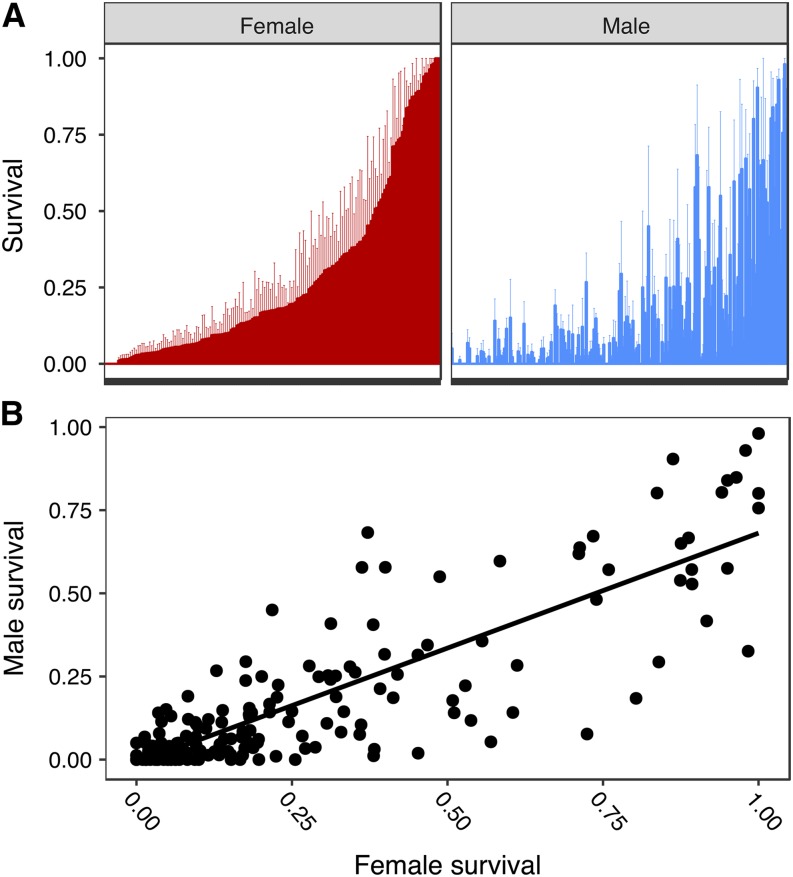
Adult survival phenotype showing A.) mean survival ± SE for each line after 6 h of anoxic exposure. Survival is sorted by female survival. B) Male and female survival was strongly correlated (r = 0.839, P < 0.0001).